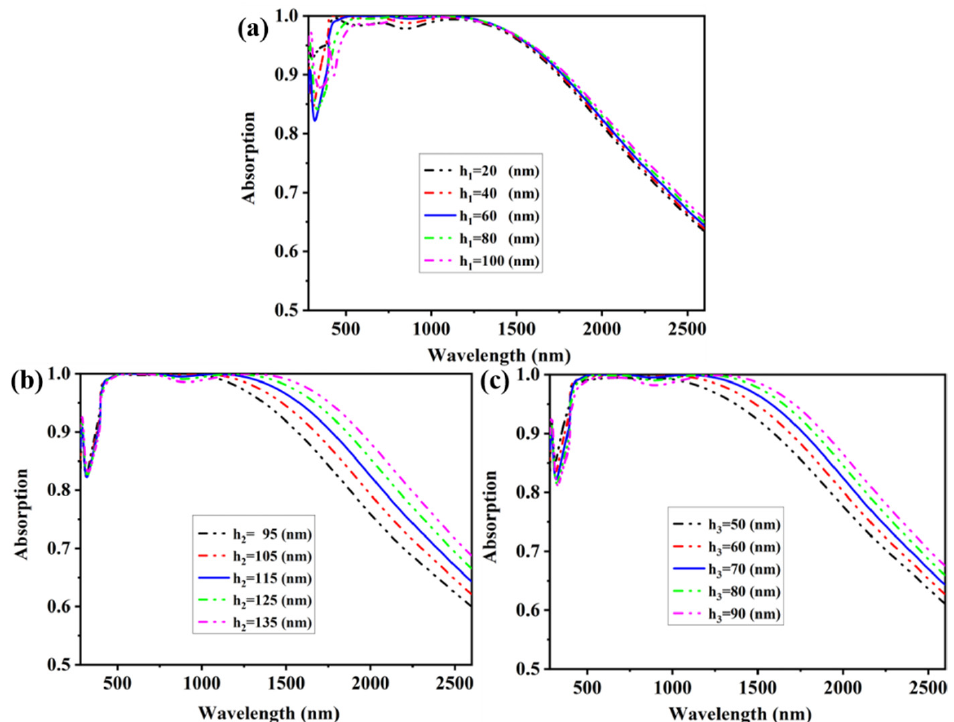
Figure 12. ( a ) The influence of the thicknesses of top Al 2 O 3 layers on the absorption. ( b ) The influence of the thicknesses of mid metal Ti layers on the absorption. ( c ) The influence of the thicknesses of middle Al 2 O 3 layers on the absorption.